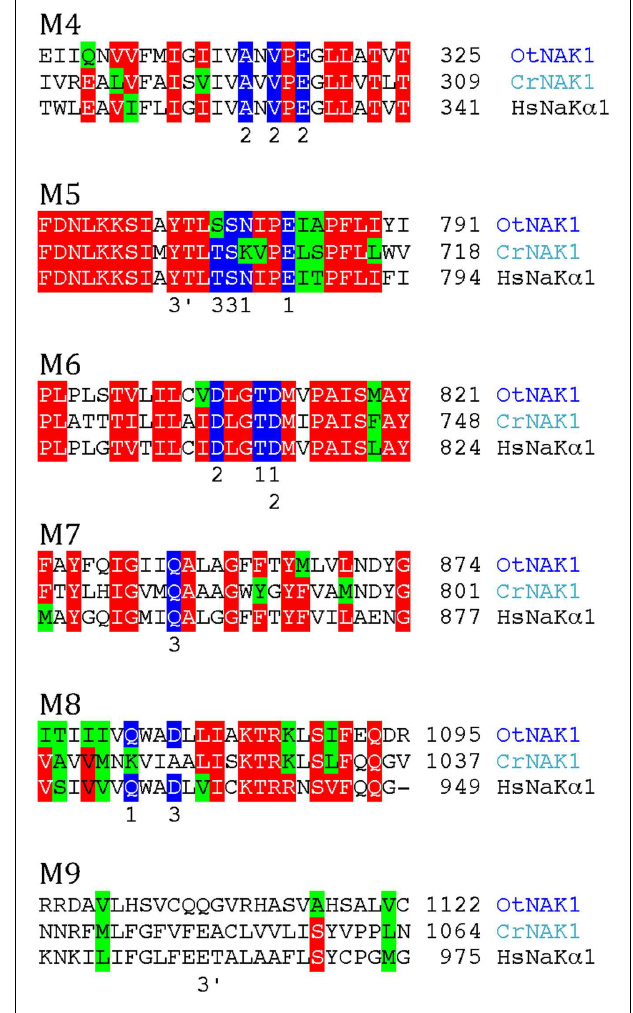
FIGURE 8 |Alignment of predicted transmembrane segments of putative chlorophyte Na + /K + -ATPases (OtNAK1 and CrNAK1) with similar regions in the human Na + /K + -ATPase α 1 subunit (ATP1A1; P05023). Residues that in Na + /K + -ATPase are likely to contribute with oxygen atoms for coordination of Na + (Morth et al., 2007) are marked by blue. Numbers above these residues refer to which of the three Na + sites (1–3) they contribute to. Residues contributing to an alternative Na + site (site 3b) are marked 3 (cid:48)